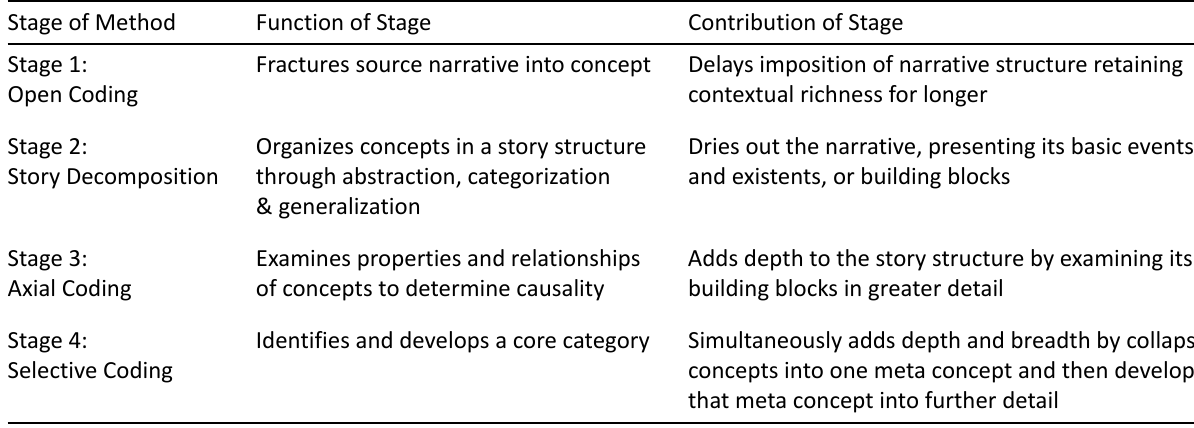
Table 1. Steps of the extended narrative